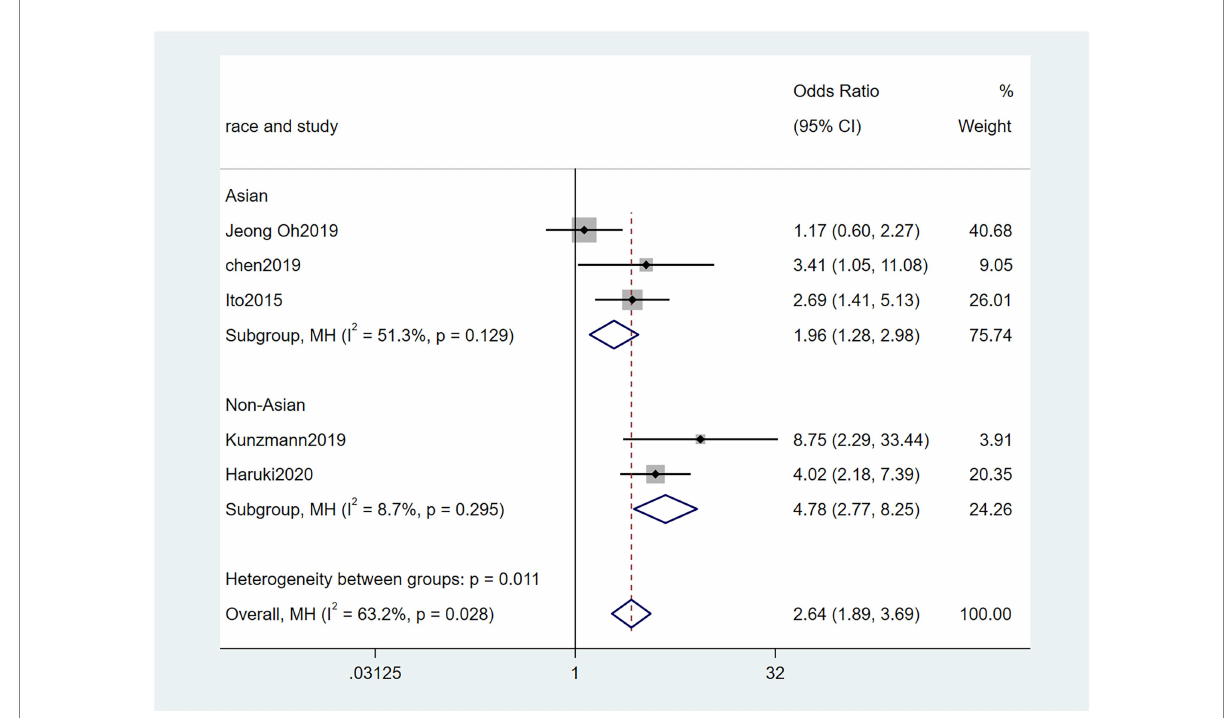
FIGURE 7 Forest plot of the relationship between Fusobacterium nucleatum and MSI status in